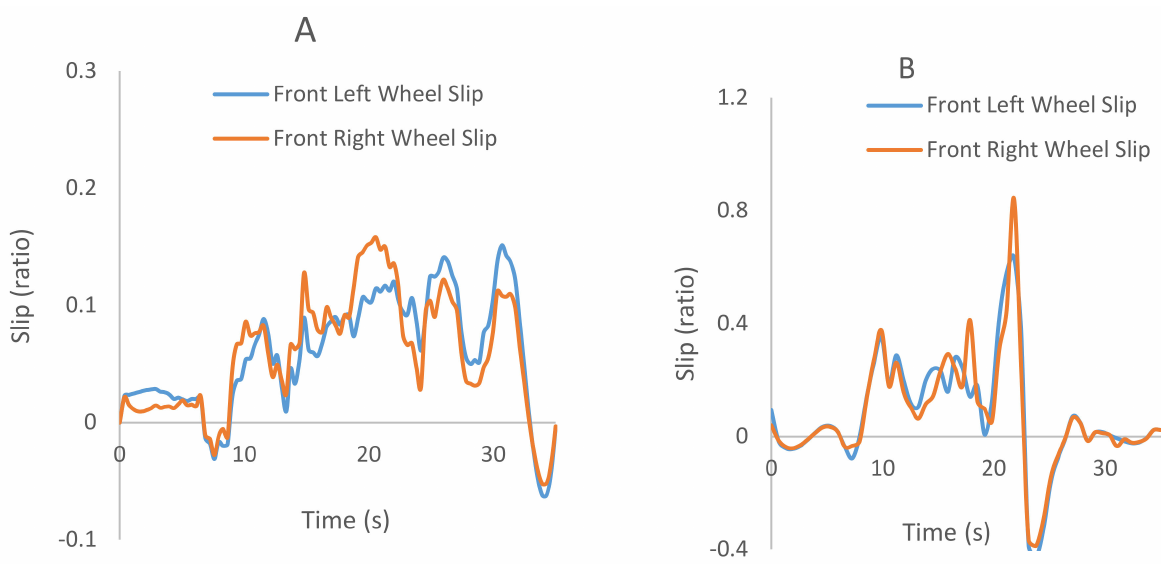
Figure 13. Slip ratio performances ( A ) with control and ( B ) without